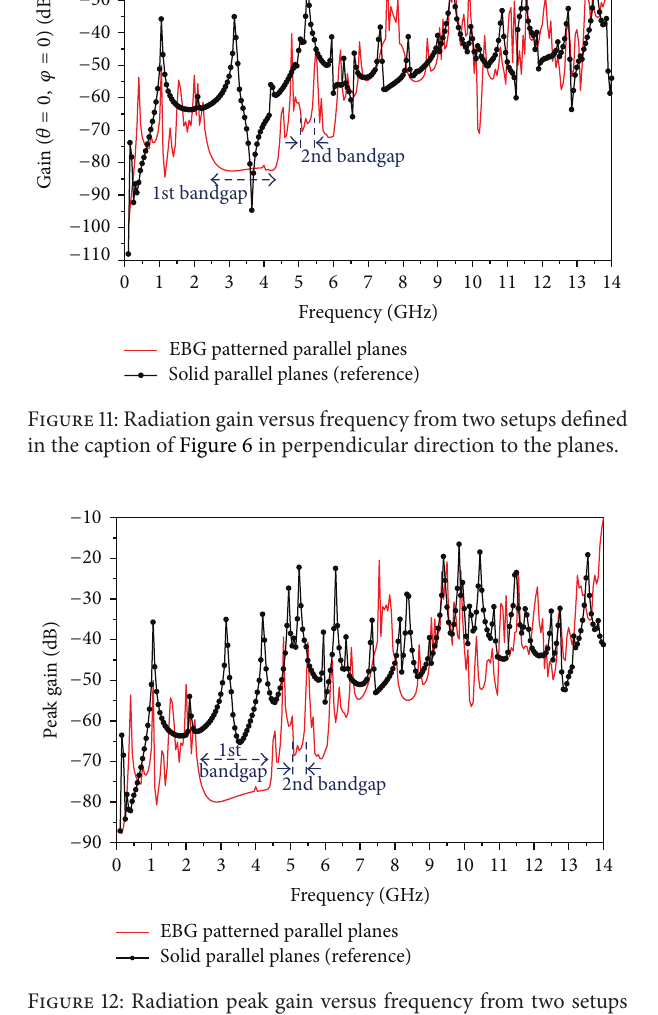
Figure 12: Radiation peak gain versus frequency from two setups defined in the caption of Figure